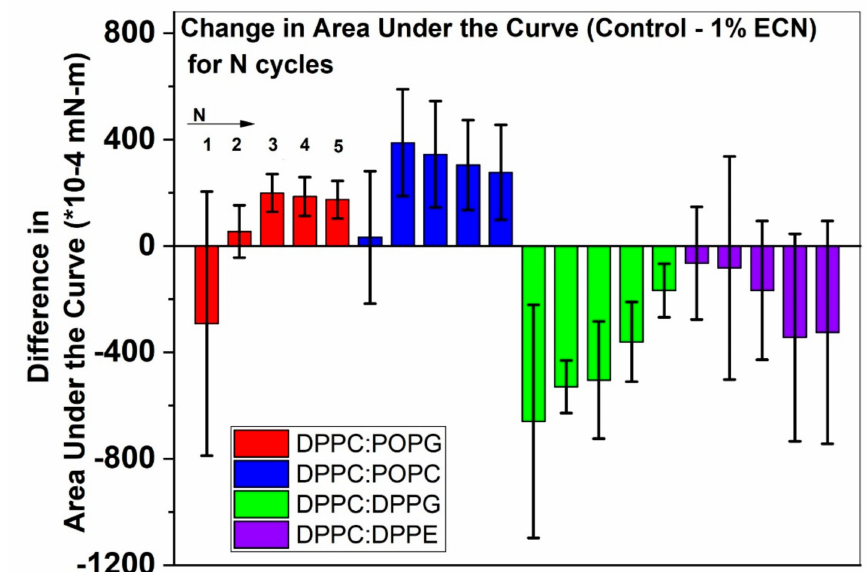
Figure 5. Di ff erence in the area under the curve between control and samples containing 1% ECN for each compression / expansion isotherm. DPPC:POPG is shown by the red bars, DPPC:POPC by blue, DPPC:DPPG by green and DPPC:DPPE by purple. Each bar represents the mean of 3 samples. The control data is independent from that of the samples containing